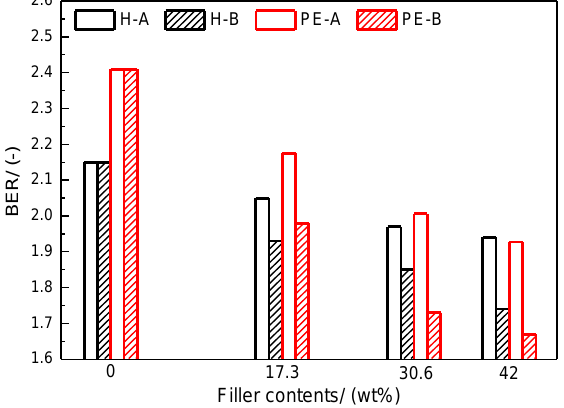
Figure 7. BERs of samples at gas velocity of 0.93 cm/s.